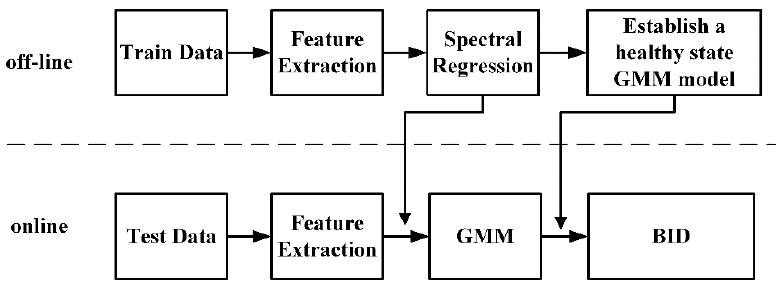
Figure 1. Flowchart of proposed performance degradation assessment method. GMM: Gaussian mixture model; BID: Bayesian inference distance.